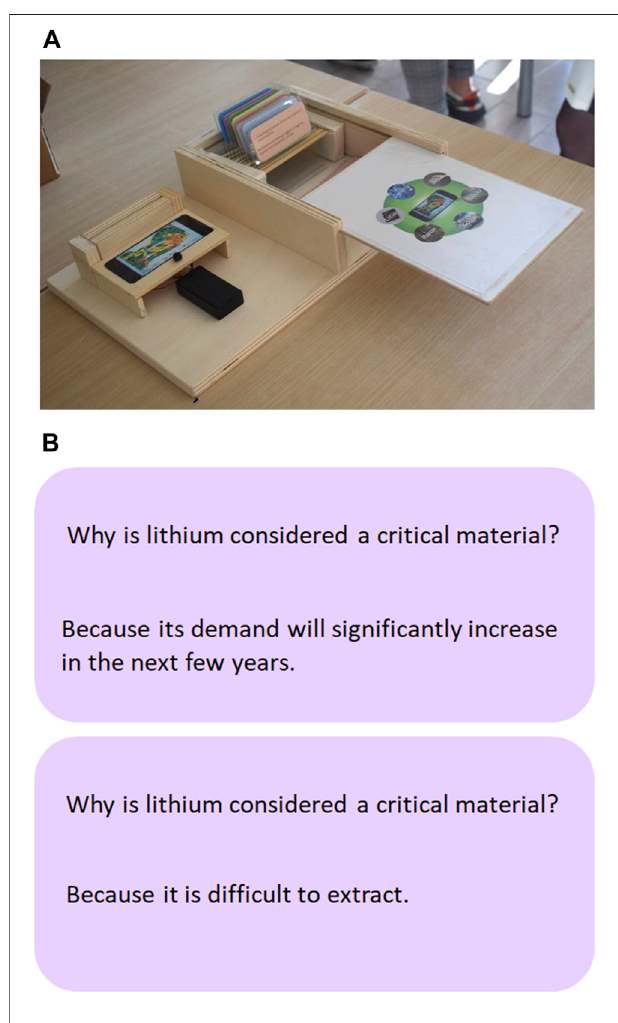
FIGURE2|(A) Boardgamerealizedbystudents ofClass3:thecircuitis on the left while the box, containing the glass platelets where the questions are printed, is on the right . (B) Example of labels where the question is followed either by the correct answer (top) or by the wrong answer (bottom)